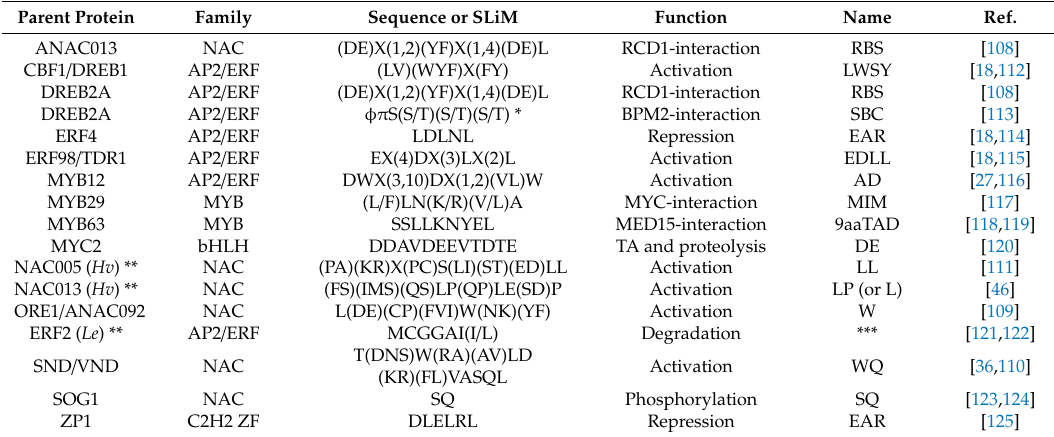
Table 1. Selected SLiMs and sequence motifs in IDRs of plant